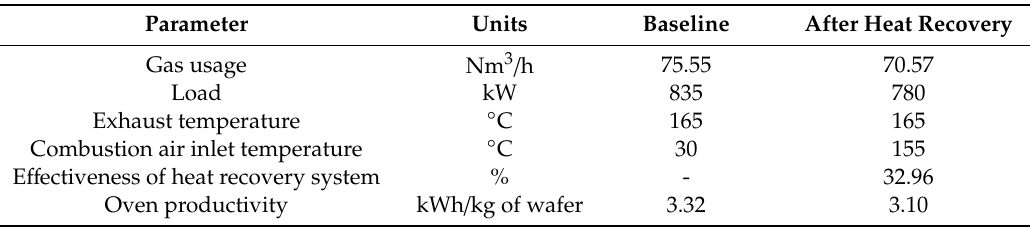
Table 7. Key performance indicators of the industrial-scale baking oven before and after heat recovery to preheat combustion air of a single